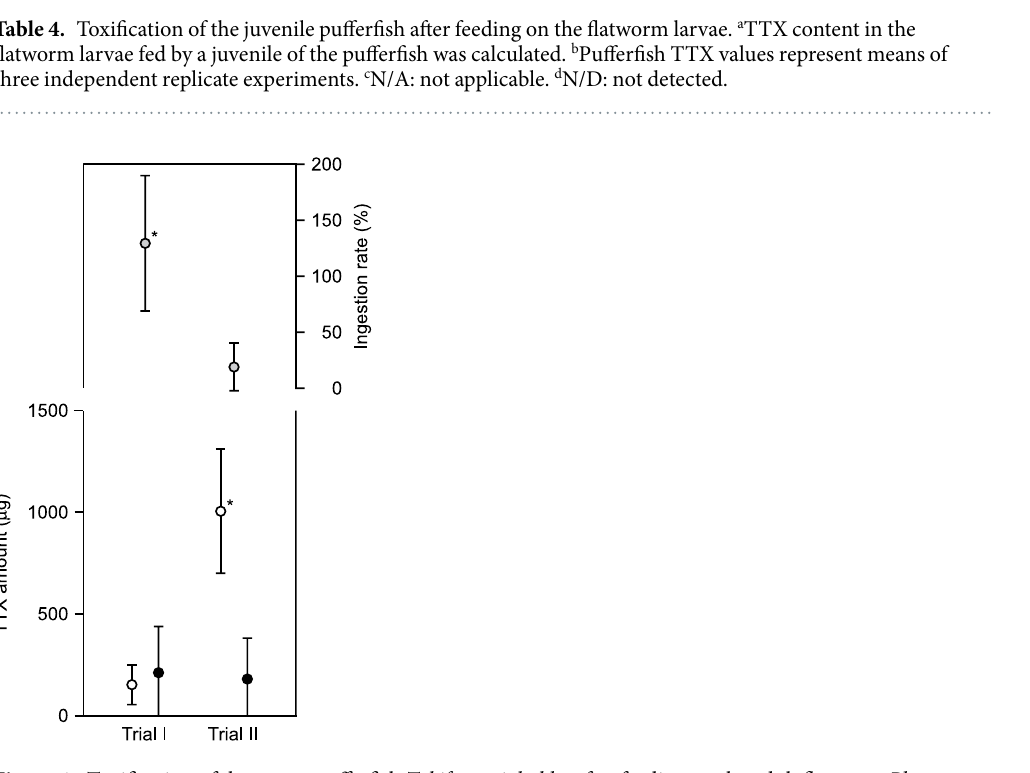
Figure 4. Toxification of the young pufferfish Takifugu niphobles after feeding on the adult flatworm Planocera multitentaculata . Closed circles refer to TTX accumulation in the pufferfish after feeding on half of one flatworm, while the open circles refer to the accumulation in half of one flatworm. Non-toxic pufferfish were used as a predators, and the toxic flatworms were used as prey. The flatworms collected in April and May were subjected to trial I and trial II of the toxification experiment (see text), respectively. Gray circle refers to the rate of accumulation of TTX in the pufferfish after feeding on the flatworm. Values are the mean of nine independent replicate experiments. Bars represent means ± standard deviation. Student’s t -test was employed for statistical comparison ( * P <